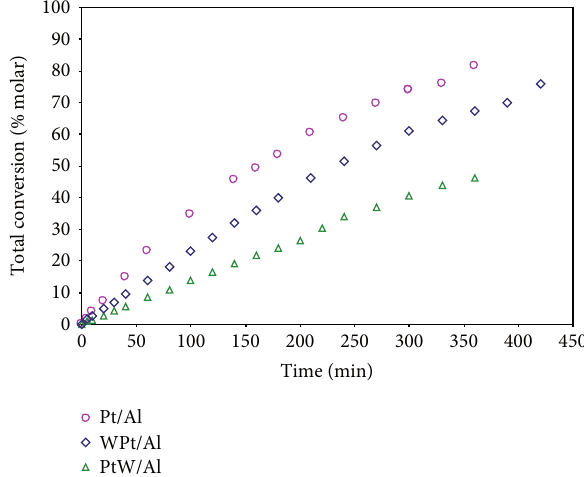
F 5: Styrene total conversion as a function of time. Sulfur- doped